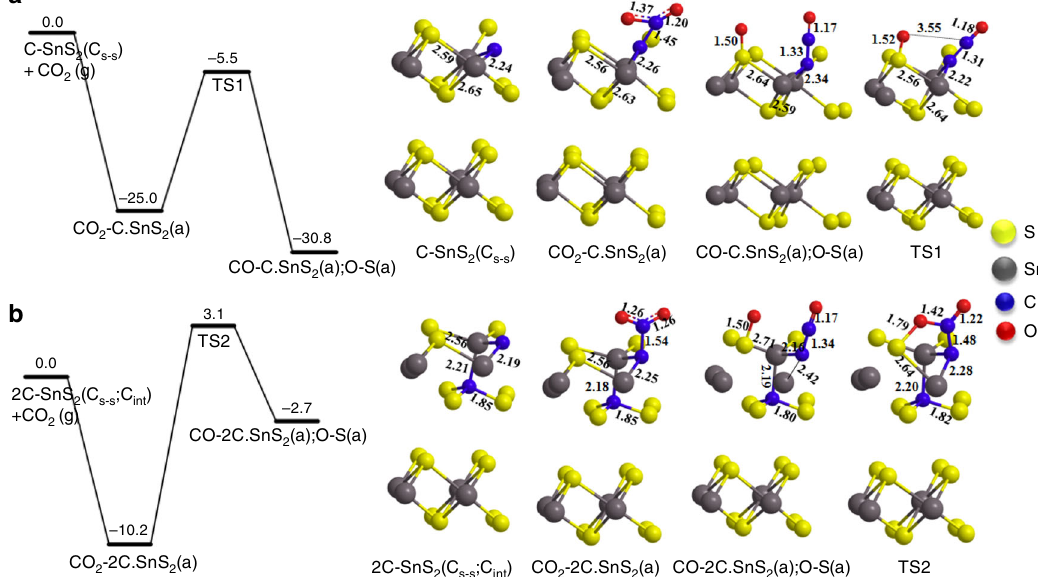
Fig. 4 Theoretical energy calculation by DFT. a , b Potential comparative free energy of CO 2 adsorption, and dissociation energy on carbon-doped SnS 2 [C- SnS 2 (C s-s ) and 2C-SnS 2 (C s-s : C int )] with their corresponding model structure (Unit: kcal mol − 1